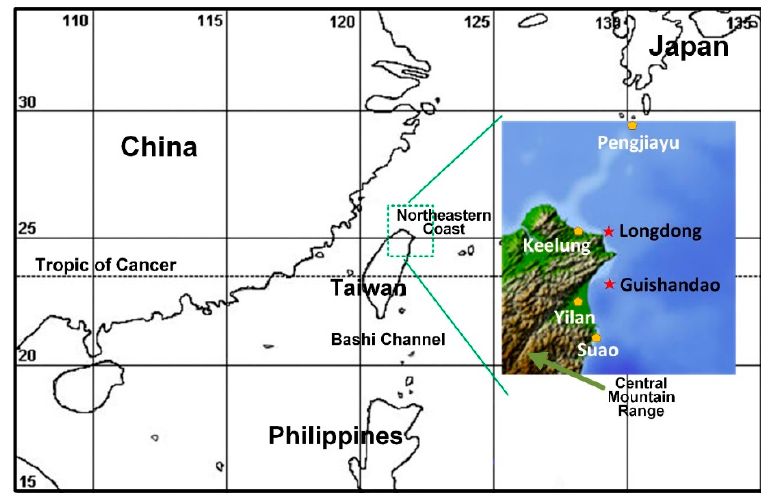
Figure 1. Northeastern coast of Taiwan and the location of the relevant test stations.